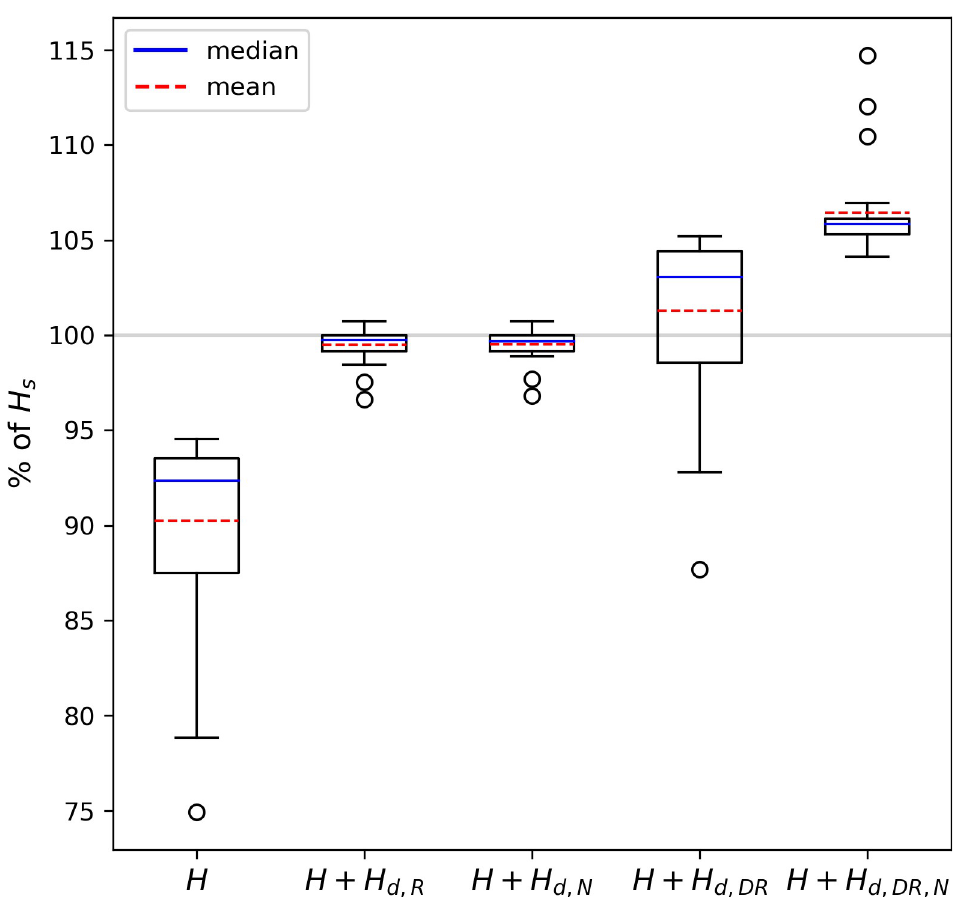
Fig 7. Comparison of different correction methods. The distribution of the heat flux H among all simulations is shown in box plots, where the blue line represents the median and the dashed red line represents the mean. At the very left, the distribution of the uncorrected H at 0.04 z is shown. In second and third place, the H corrected with our i approaches A and B are shown. In the fourth place, H corrected with the method by De Roo et al. [58] is shown. At the very right, H is corrected with a combination of F 1 and F 2 derived by De Roo et al. [58] and F 3 derived in approach B in this